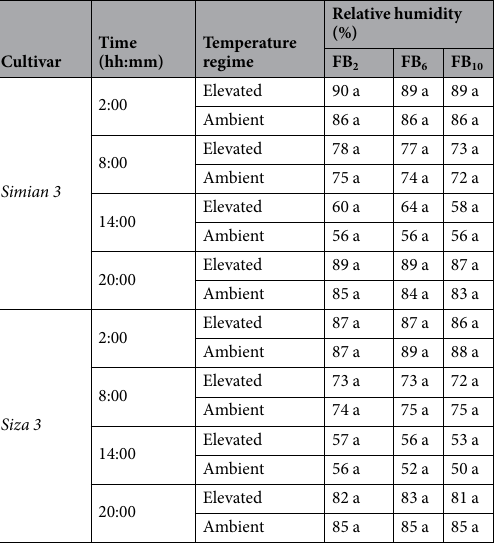
Table 2. Relative humidity in cotton field within 24 hours, at 15 DPA in 2010. FB 2 , FB 6 , FB 10 represent the 2 nd , 6 th , 10 th fruiting branch, respectively. Data followed by different letters between two treatment at one time on the same FB represent statistically significant differences at p ≤ 0.05 level based on ANOVA. Data were recorded at the 15 DPA based on FB 6 , 1 st